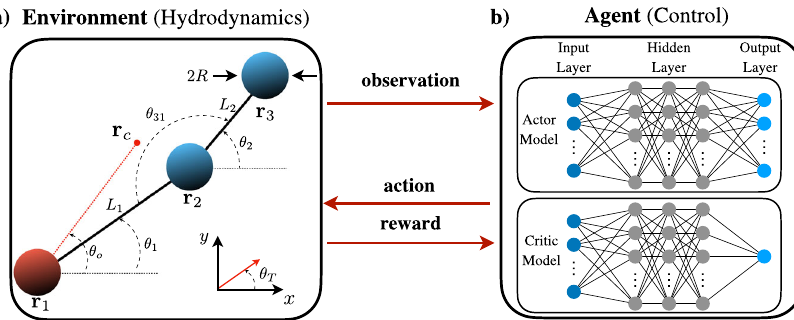
Fig. 1 Schematics of the model microswimmer and the deep neural network with Actor-Critic structure. a Schematic of the model microswimmer consisting of three spheres with raidus R and centers r i ( i = 1, 2, 3). We mark the leftmost sphere r 1 as red and the other two spheres r 2 , r 3 as blue to indicate the current orientation of the swimmer. The spheres are connected by two arms with variable lengths L 1 , L 2 and orientations θ 1 , θ 2 , where θ 31 is the intermediate angle between two arms. The swimmer's orientation θ o is de fi ned based on the relative position between the swimmer's centroid r c = ∑ i r i /3 and r 1 as θ o ¼ arg ð r c (cid:2) r 1 Þ . The swimmer is trained to swim along a target direction θ T . b Schematic of Actor-Critic neural networks. Both networks consist